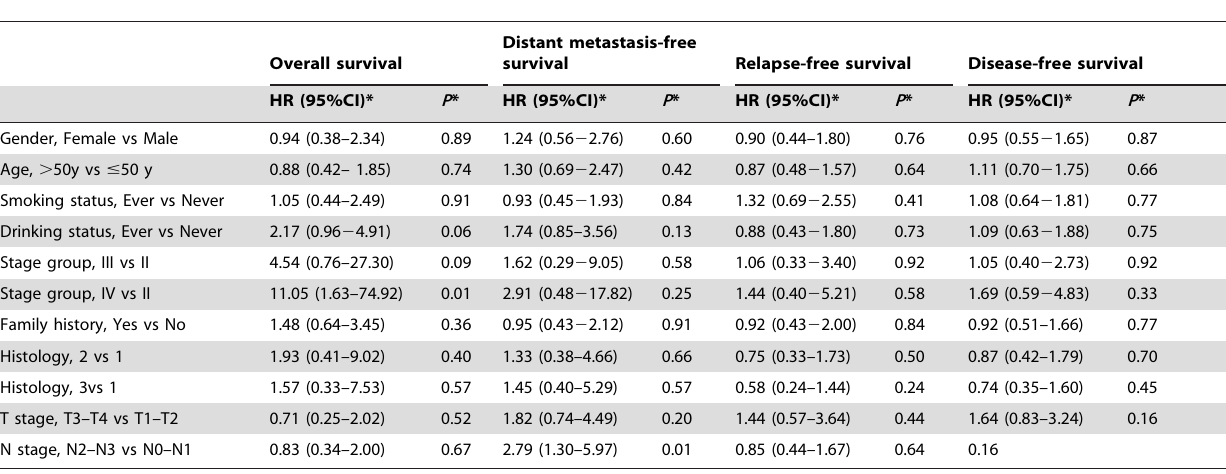
Table 5. Effect of prognostic factors on survival in multivariable analyses.